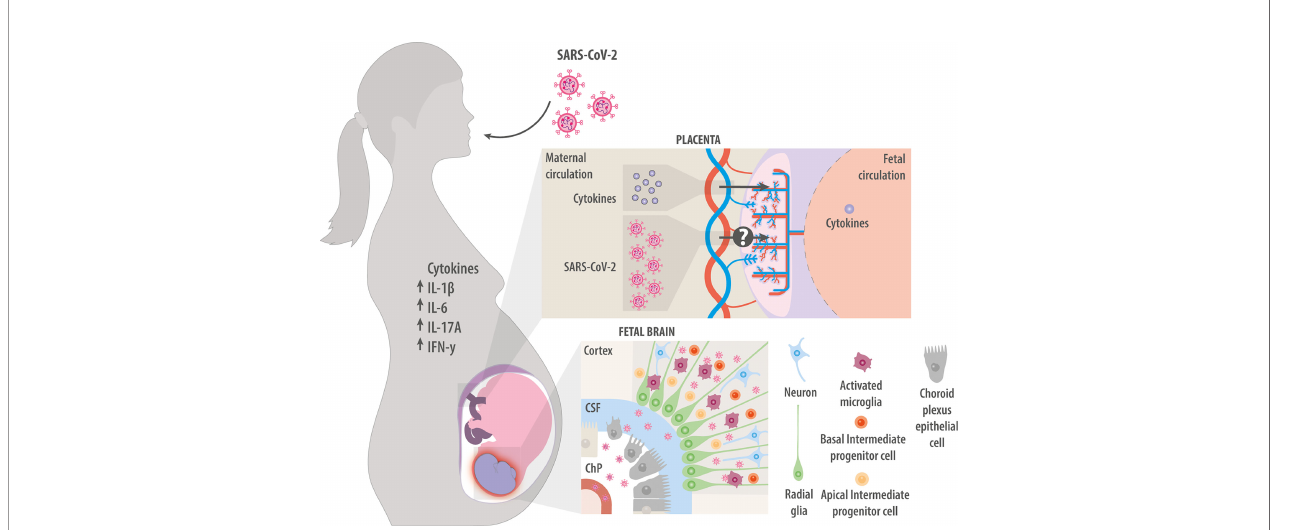
FIGURE 3 | Maternal infection with SARS-CoV-2. Maternal infection with SARS-CoV-2 increases levels of cytokines IL-1 b , IL-6, IL-17A, and IFN- g in the mother. These factors can cross the placenta and induce neuroin fl ammation in the fetal brain. Whether the virus itself can also cross the placenta and infect the fetus is unclear. Studies in vitro suggest that the virus can infect fetal choroid plexus cells, where they disrupt production of cerebrospinal fl uid and compromise the integrity of the blood-brain barrier, allowing immune cells and cytokines to enter the developing brain. Studies in vitro have also suggested that SARS-CoV-2 can directly infect NPCs and